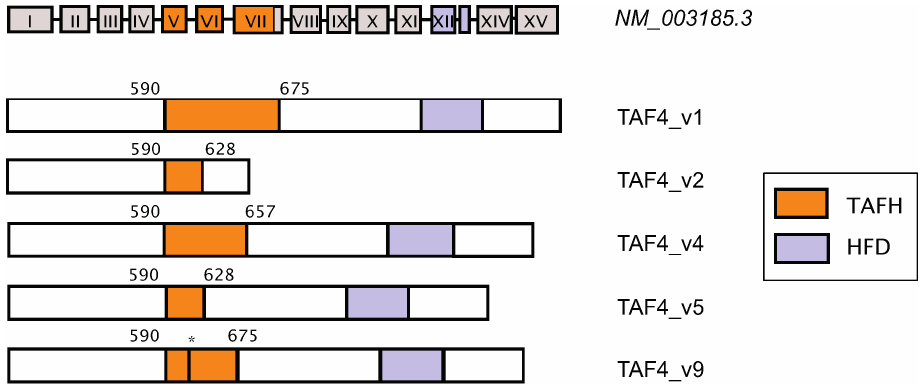
Figure 2. Alternative splicing of human TAF4 ( NM_003185.3 ) leads to a variety of protein isoforms. TAF4 gene structure and major TAF4 isoforms with deletions in the co-activator-binding hTAF4–TAFH domain are outlined. Some isoforms of